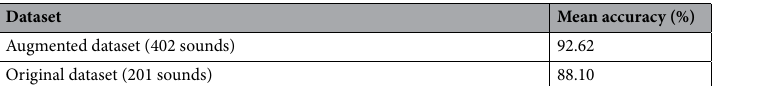
Dataset Mean accuracy (%) Augmented dataset (402 sounds) 92.62 Original dataset (201 Table 9. The comparison of the original and augmented datasets using the same proposed method (CNN- LSTM-Attention-Leaky ReLU).